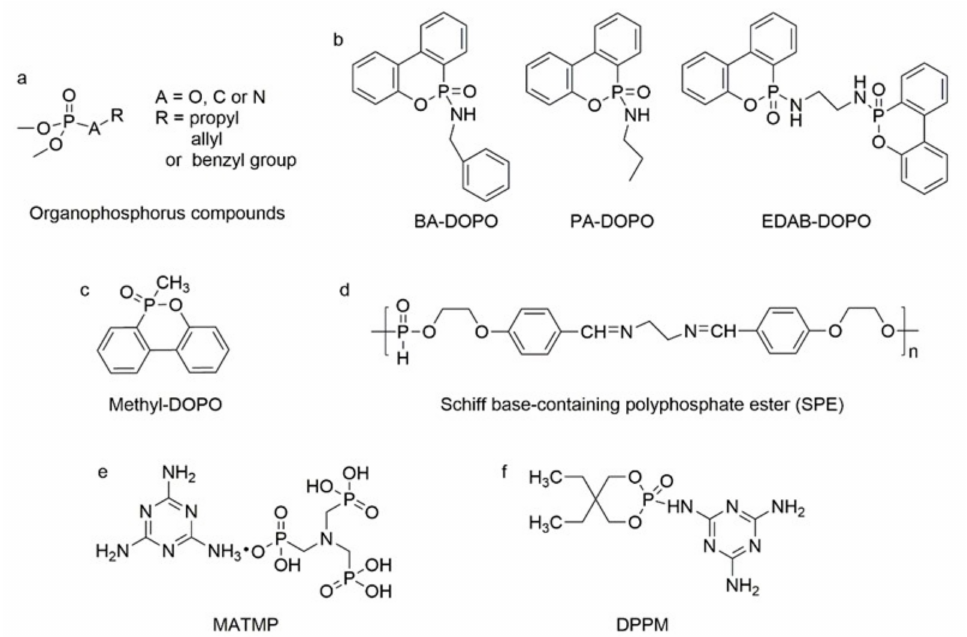
Figure 3. Chemical structures of phosphorus-containing and P–N flame retardants: ( a ) phosphonate, phosphate, and phosphoramidite flame-retardants; ( b ) DOPO phosphoramidite flame-retardants; ( c ) methylated DOPO flame-retardant; ( d ) Schiff base polyphosphate flame-retardant; ( e ) intu- mescent phosphoric acid based flame-retardant; ( f ) one-component intumescent phosphoramidite